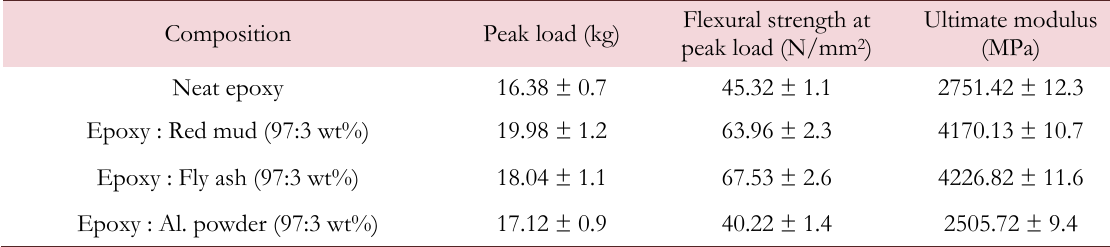
Table 5: Flexural test results of composites at 3 wt% of filler